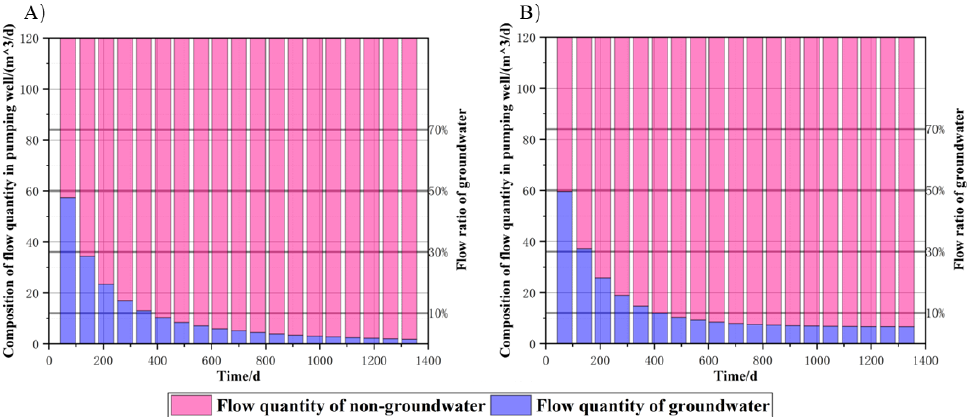
Figure 6. The bar graph of the composition of flow quantity in pumping wells at the whole C1 and C2 mining areas with the change in time (based on the average concentration from all pumping wells). Note: ( A )—Plan A; ( B )—Plan B. Table 1. Comparison of the day for plan A and plan B to reach the corresponding “flow ratio of groundwater”.